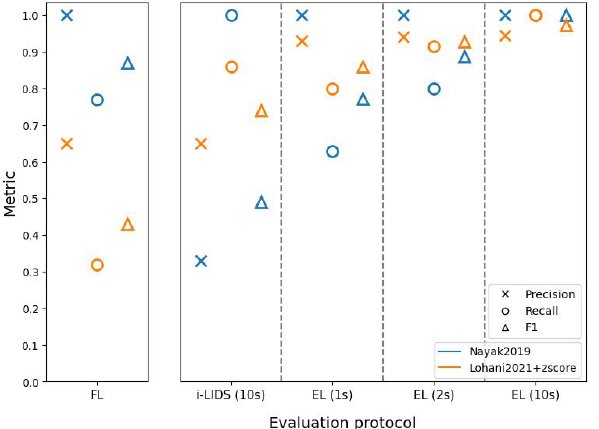
Figure A1. The results of two methods: [47] (in blue) and [6] with z-score (in orange), tested on view 2 of i-LIDS test set with intruder at close distance from camera. The abscissa represents three evaluation protocols: frame-level (FL) (on left subfigure), i-LIDS and edge-level (EL) (on right subfigure). i-LIDS is evaluated by default for 10 s whereas, for EL, we show results for 1, 2 and 10 s. The ordinate represents values of three metrics: precision, recall and F 1